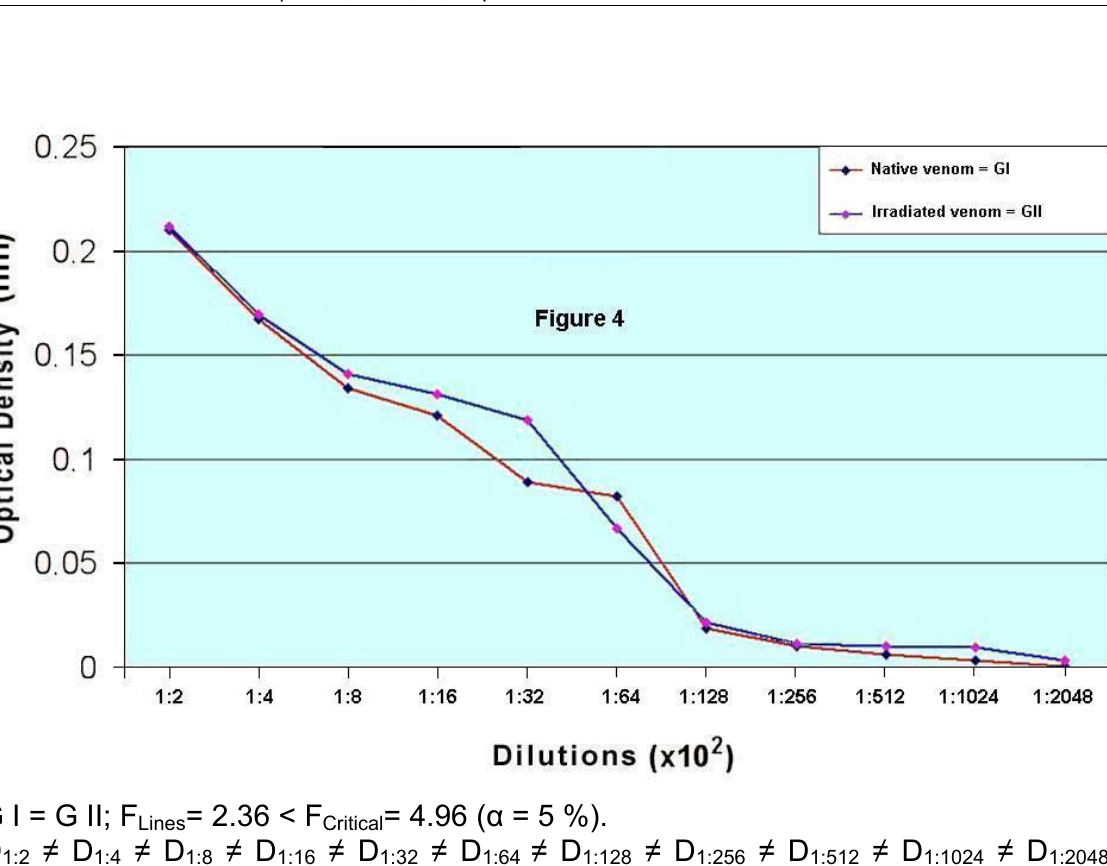
Figure 4: Distribution of the optical densities mean values in the ELISA test, at the 60 th day, in different dilutions (1:200 to 1:204800), using serum extracted from animals inoculated with native (GI) and cobalt 60-irradiated (GII)